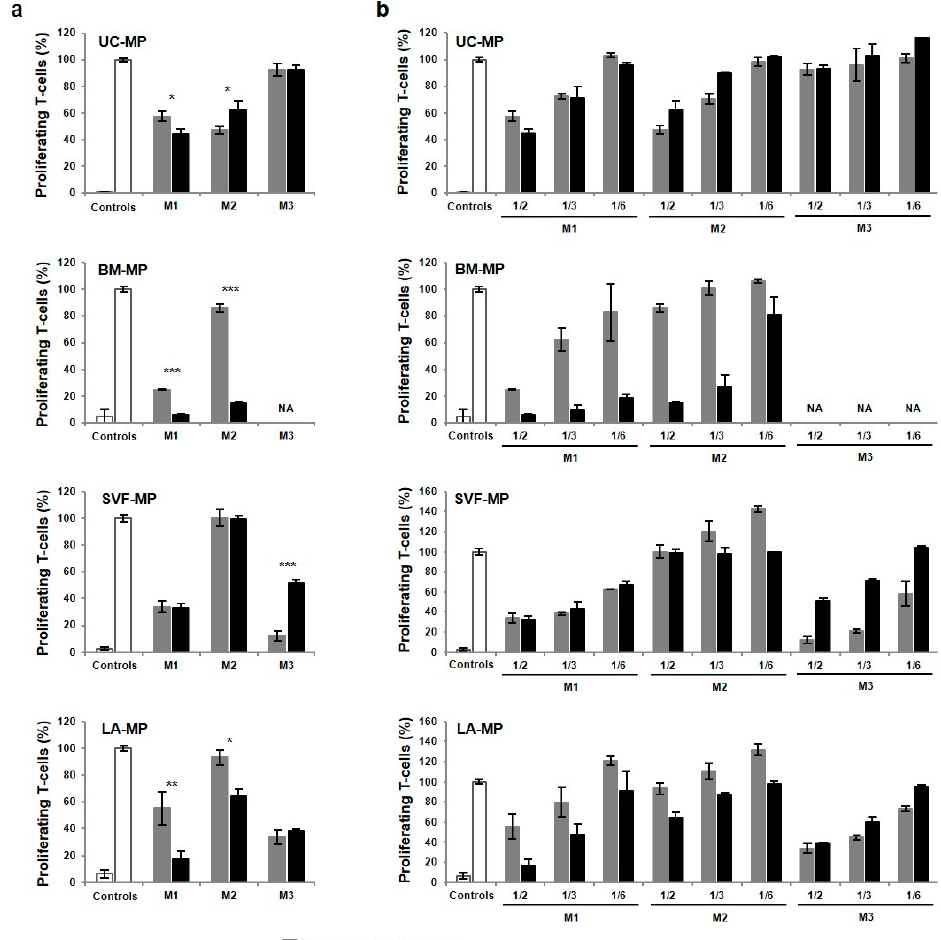
Figure 8. Immunosuppressive ability of tissue-specific MSC-based MPs. The ratio of CFSE-labelled proliferating T-cells after co-cultivation with MPs normalized to stimulated T-cells (right white control column); unstimulated T-cells, left white control column. ( a ) Proliferation of T-cells suppressed by normal and primed MPs expanded in M1, M2 and M3 media. ( b ) Dose-dependency of the suppressive effect evaluated by seeding MPs in three different concentrations: cell number of PBMC/MP = 1/2, 1/3 and 1/6. Results refer to the mean ± SD, n = 3. Statistics: unpaired t test (* p < 0.05, ** p < 0.01, *** p < 0.001). NA—not available.